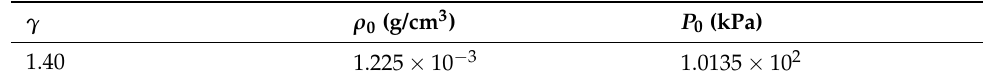
Table 2. Gamma law parameters for air.